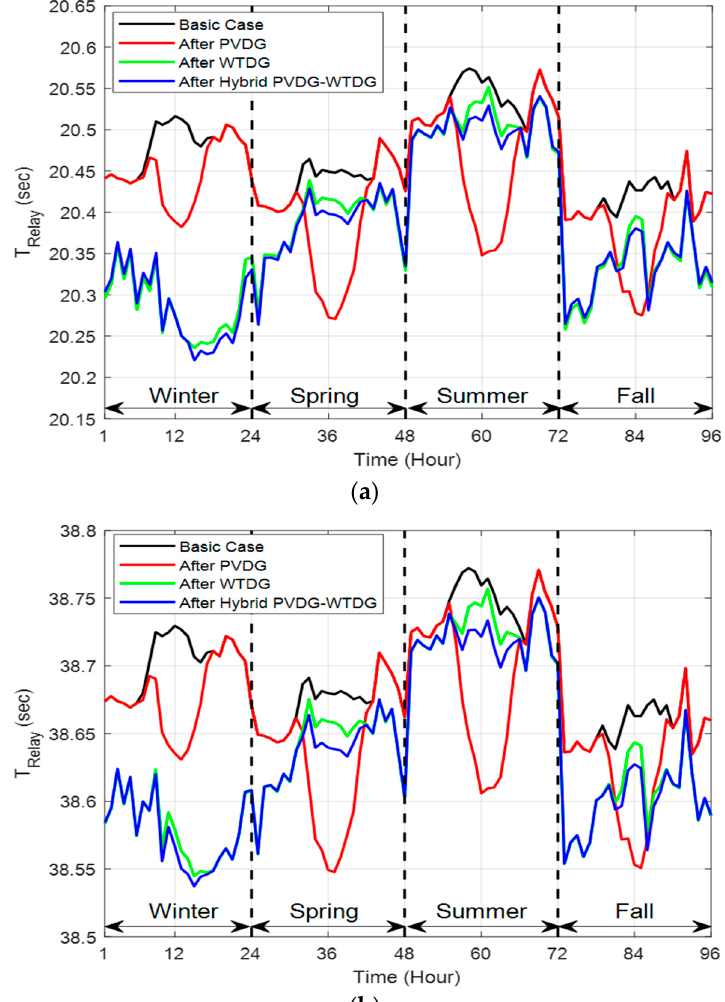
Figure 16. The seasonal variation of the overcurrent relay’s total operation time: ( a ) IEEE 33-bus; ( b ) IEEE 69-bus.